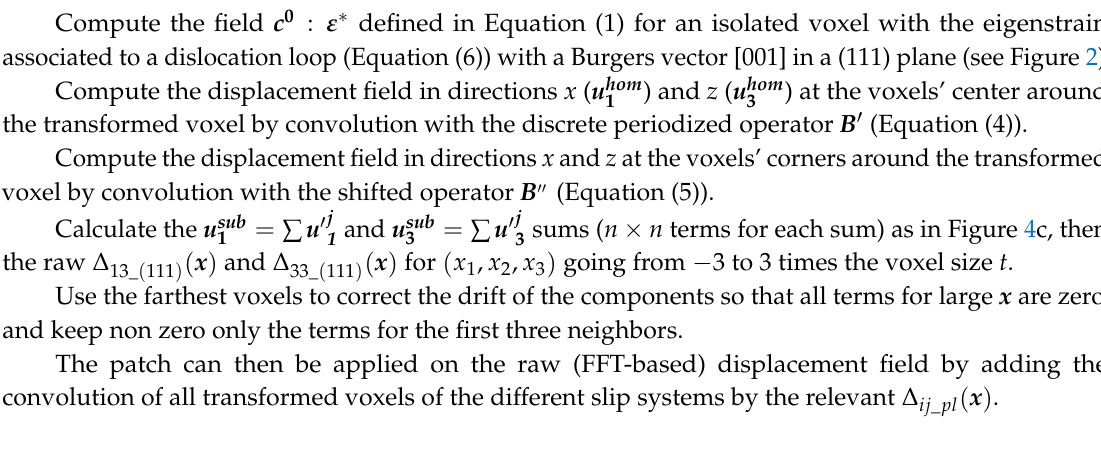
Figure 4. ( a ) 2D representation of the computational grid. The black dots correspond to the voxels centers. A voxel with center O is discretized in 4 × 4 in 2D (4 × 4 × 4 in 3D) sub-voxels. The red sub-voxels have a non-zero eigenstrain. We want to compute the displacement field at point A, due to these deformed sub-voxels centered at B j . ( b ) Displacement field generated by a deformed sub-voxel centered at O on a row of sub-voxels centered at B j such as OA j = B j A . The sum of these displacements is equal to the previous displacement field. ( c ) Displacement field generated by a deformed voxel centered at O on a row of voxels (computed at the corners A (cid:48) j using Green operator B (cid:48)(cid:48) ) such as OA (cid:48) j = n B j A . This sum is equal to the previous